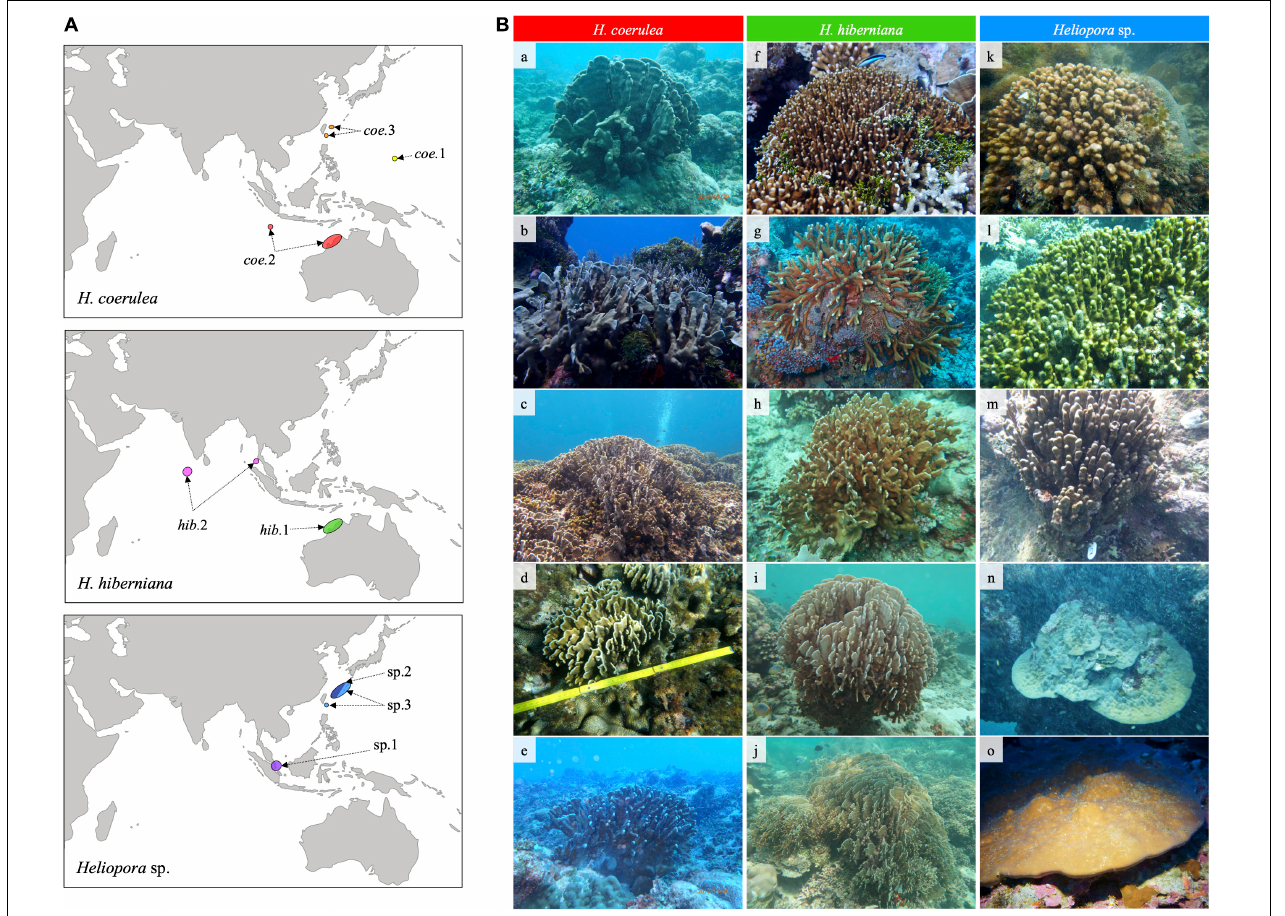
FIGURE 3 | (A) Geographical distributions of the three Heliopora spp. groups. (B) Gross morphologies of the three Heliopora spp. groups. H. coerulea group; (a) lobate growth form in Guam ( coe .1), (b) lobate growth form in northwestern Australia ( coe .2), (c) lobate growth form in Japan and (d) Taiwan ( coe .3), and (e) thick-branching growth in Guam ( coe .1). H. hiberniana group; (f) slender-branching form in the type locality in northwestern Australia ( hib .1), and (g) slender-branching and (h – j) lobate growth form in the Maldives ( hib .2). Heliopora sp. group; (k) columnar growth form in Singapore (sp.1), (l) columnar growth form in Japan (sp.2), (m) columnar growth form in Japan (sp.3), (n) encrusting growth form in Japan (sp.3), and (o) encrusting growth form in the mesophotic zone (50 m) in Taiwan